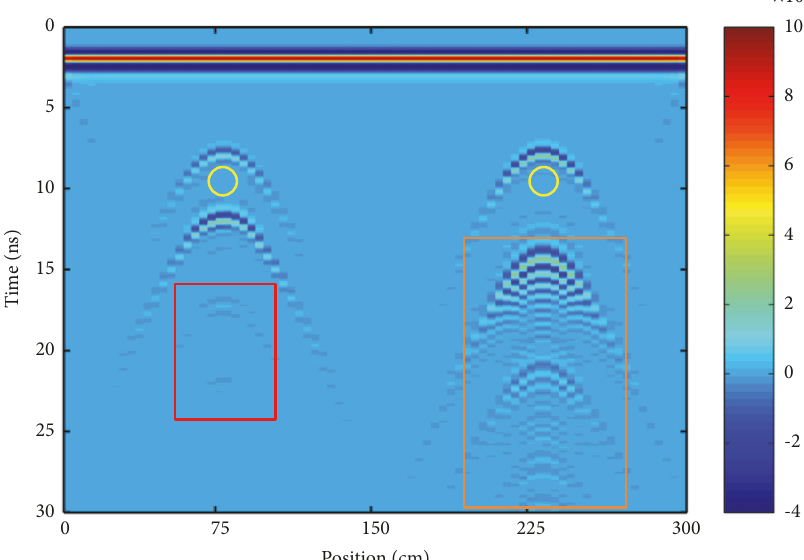
Figure 18: The wiggle trace profile of the underground pipes model simulated by the CUDA-implemented conformal SPRK methods.